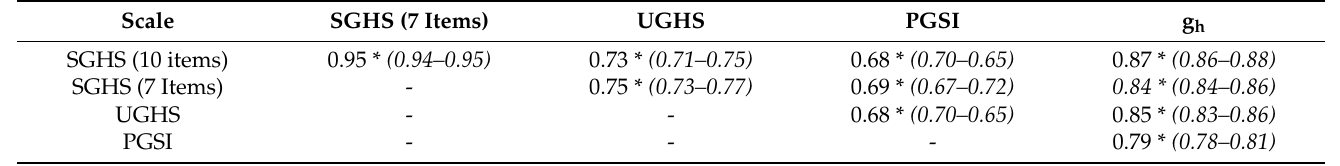
Table 3. Scale correlation matrix. Confidence intervals (95%) shown in